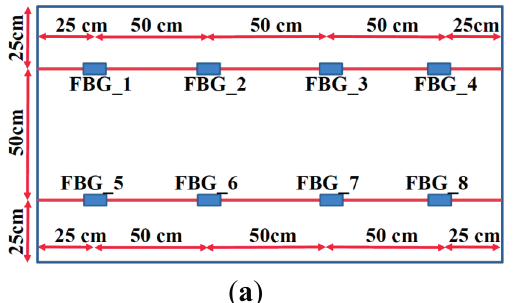
Figure 6. ( a ) Schematic of the sensorized rubber mat; ( b ) Picture of the sensorized mat (Inset: FBGs glued under the ribbed rubber